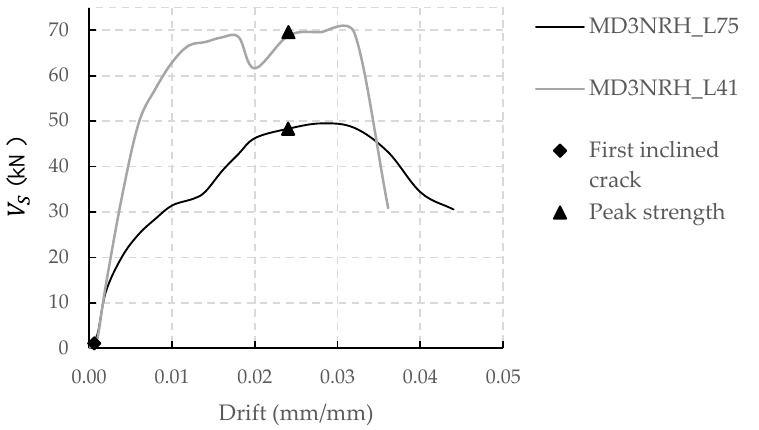
Figure 12. Contribution of joint reinforcement.